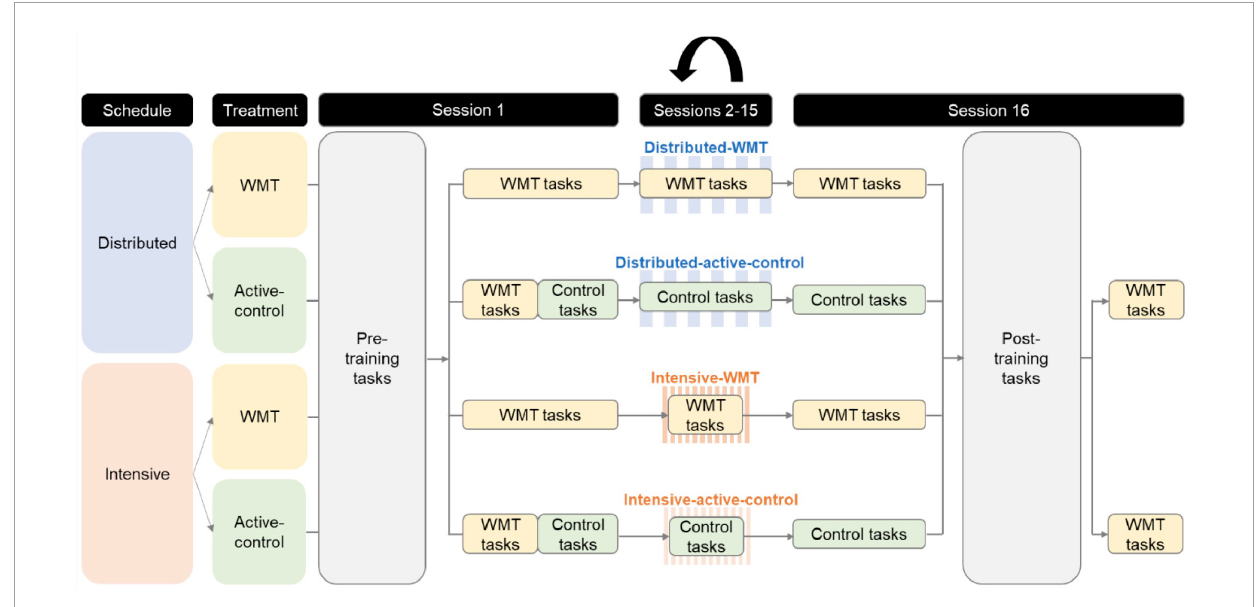
FIGURE2 Illustration of the study